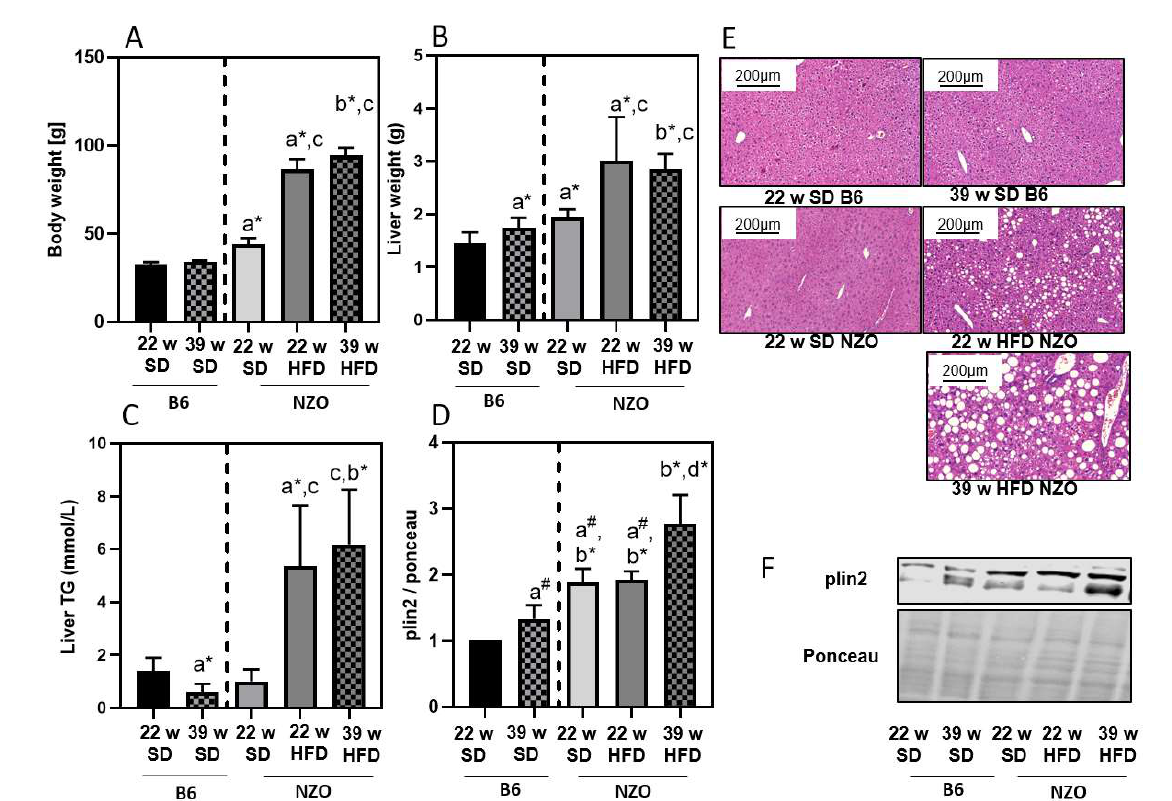
Figure 1. High-fat diet leads to enhanced liver lipid accumulation in NZO mice. B6 and NZO mice were fed by a standard diet (SD) or a high-fat diet (HFD) until the indicated age of 22 or 39 weeks. Body weight (panel A ), liver weight (panel B ), triglycerides (TG) (panel C ) and plin2 content (panel D ) were measured as described in the Methods section. Plin2 (panel D ) was determined by immunoblotting and data were normalized towards 22w SD B6 (set as ‘1’). A representative blot is shown in panel F . Representative H&E staining of liver slices to visualize the lipid droplets are shown in panel E . Statistical analysis was performed either by two-way ANOVA comparing NZO mice by diet, unpaired t -test (indicated by *) or one sample t -test (indicated by #), comparing selected samples directly. Statistical significance means: a—versus 22w B6; b—vs. 39w B6; c—vs. 22w Nzo SD; and d—vs. 22w NZO HFD. The data presented are the mean ± standard deviation, n =